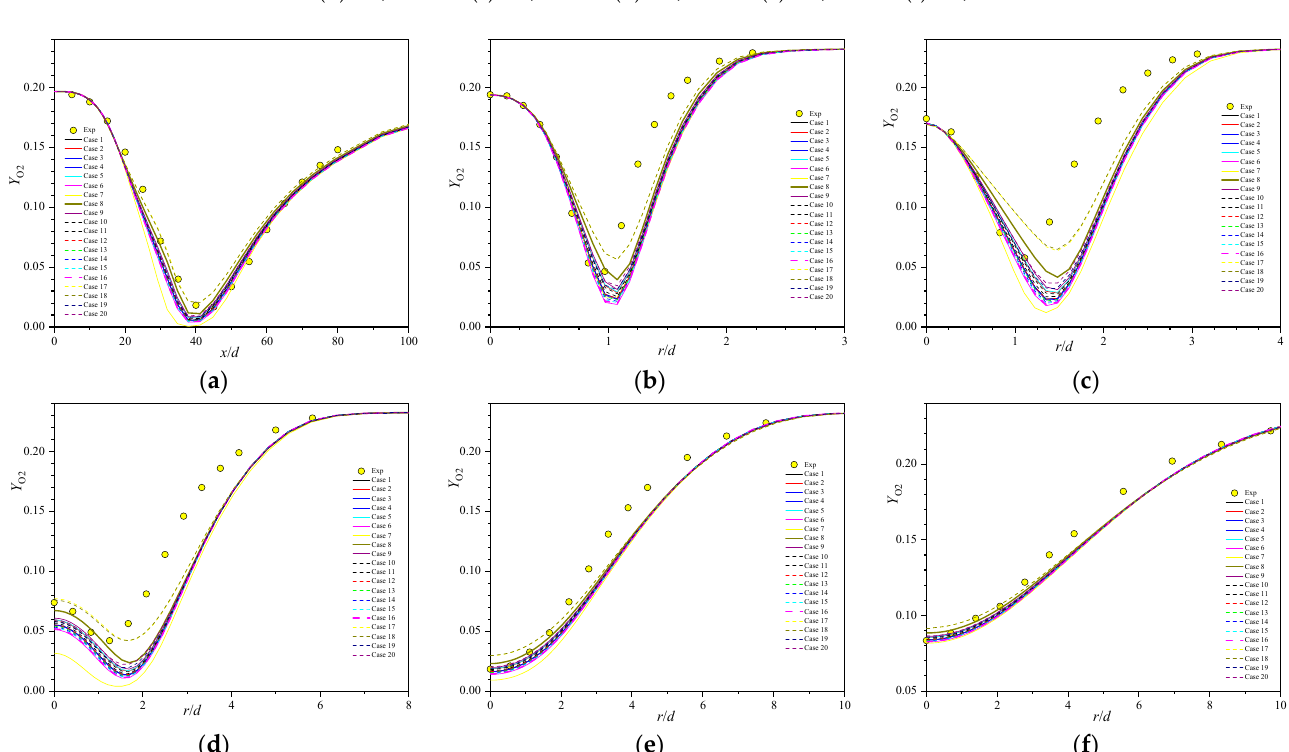
Figure 9. Comparison of measured [22,24] and predicted mean N 2 mass fraction profiles for the Sandia Flame D with 20 combinations of the primary EDC constants 𝐶 (cid:2888)(cid:2869) and 𝐶 (cid:2888)(cid:2870) . ( a ) @axis. ( b ) @ x / d = 7.5. ( c ) @ x / d = 15. ( d ) @ x / d = 30. ( e ) @ x / d = 45. ( f ) @ x / d = 60.